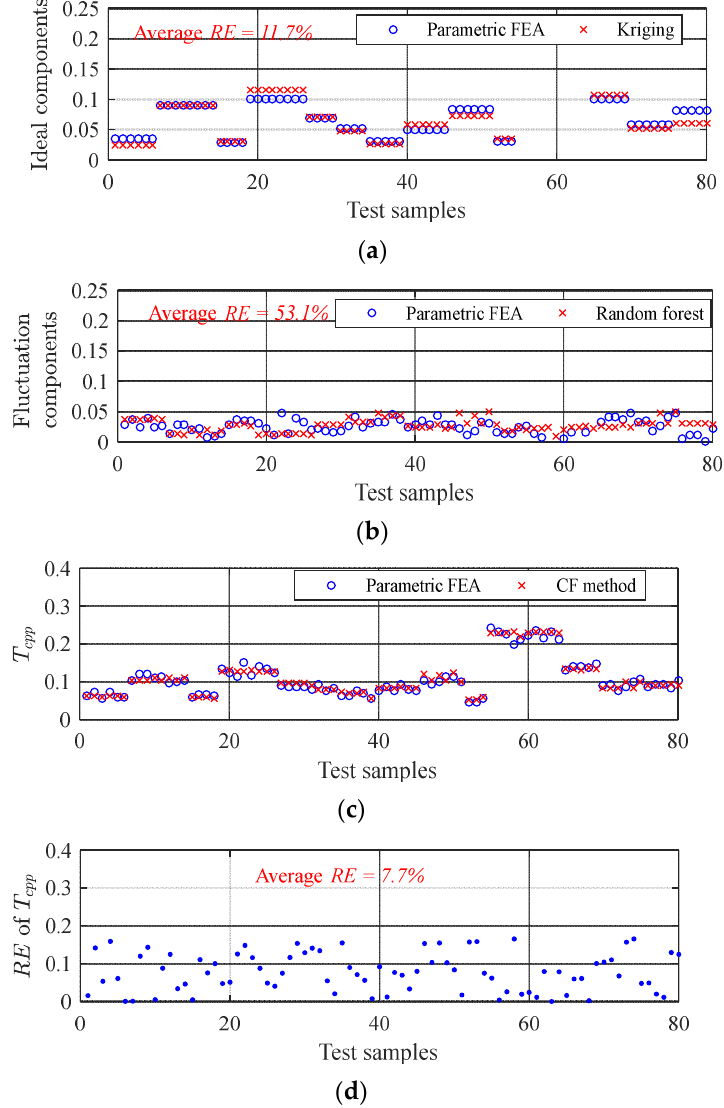
Figure 14. The approximate process and results of the CF method proposed in this paper: ( a ) ideal components of T cpp ; ( b ) fluctuation components of T cpp ; ( c ) T cpp with tolerances; ( d ) the average RE of the CF method.